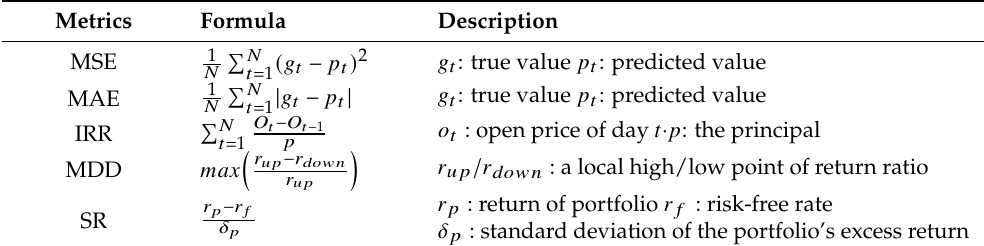
Table 1. Related evaluation indicators.